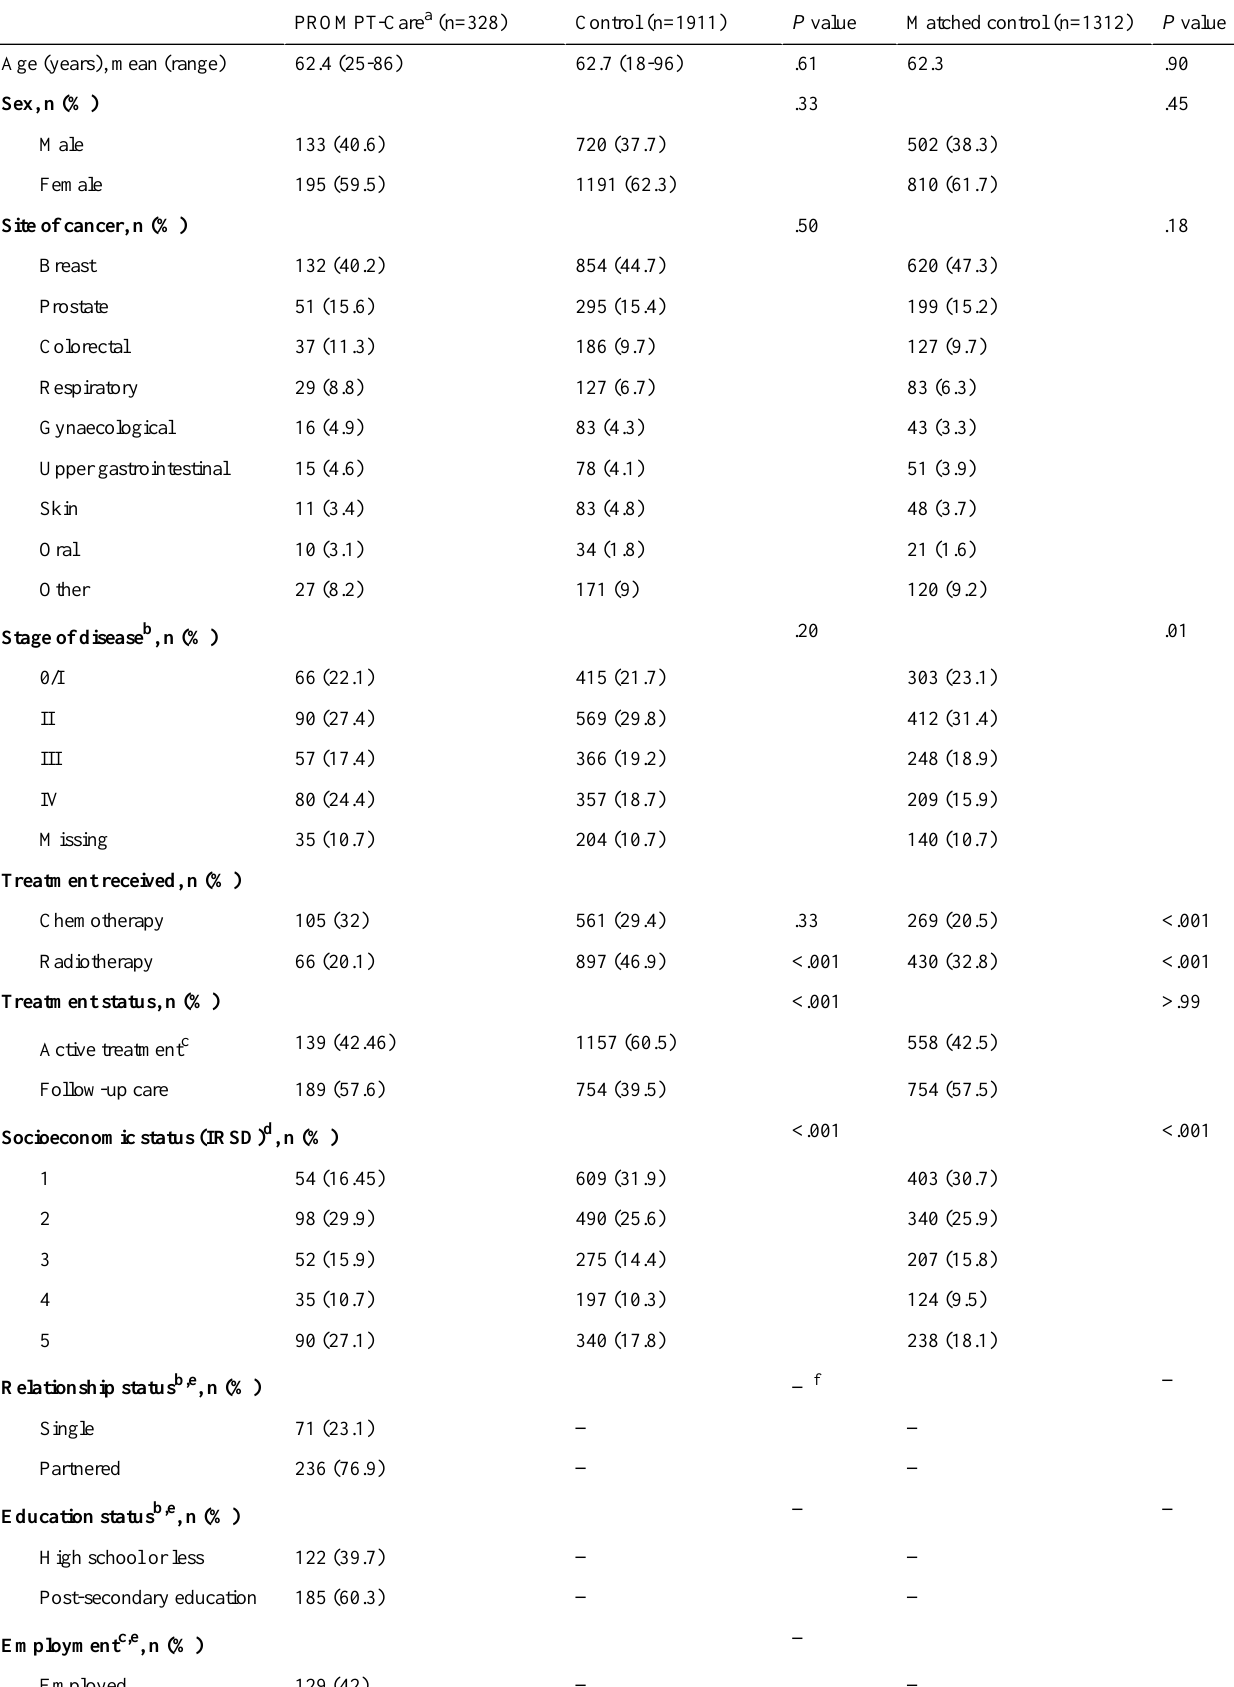
Table 1. Participant characteristics for intervention, control, and control participants matched for age, sex, and treatment